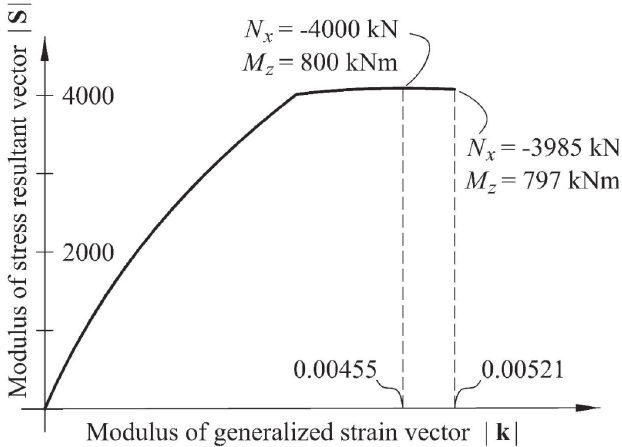
= 67.0 cm 2 ). The modulus of the s total